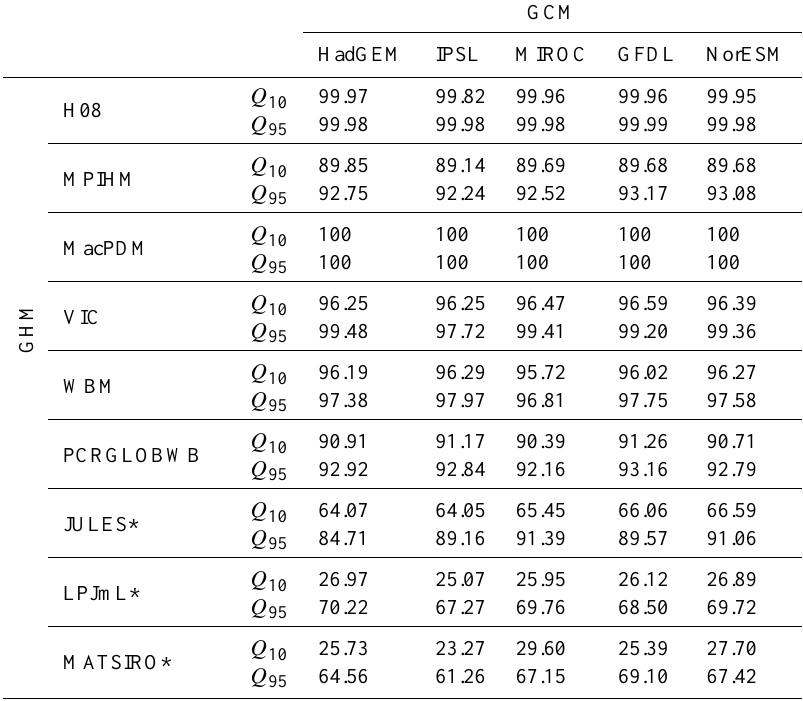
Table B1. Percentage of available land grid cells after masking per GHM–GCM model